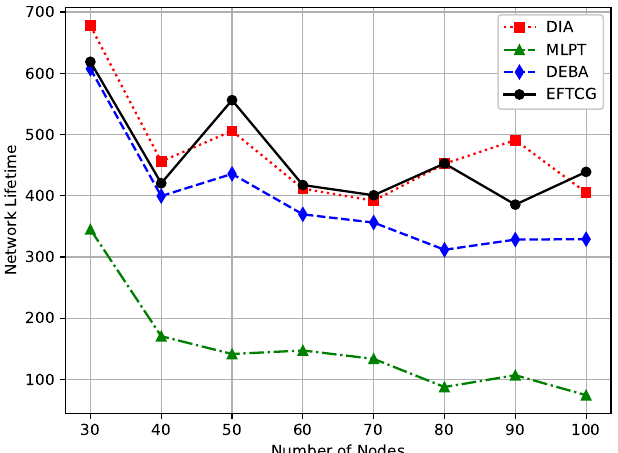
Figure 9. The comparison of the network lifetime under different